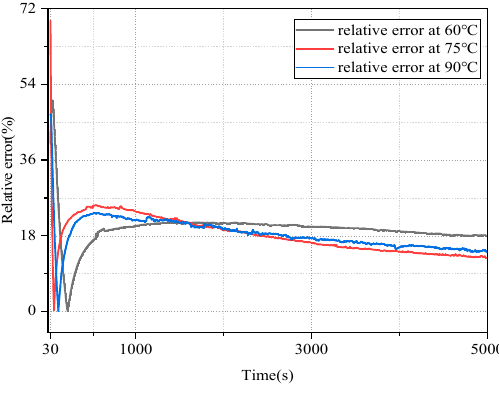
Figure 7. Relative error (RE) of the calculation curves and the measured curves. Table 8. Root mean squared error (RMSE) of calculated data.